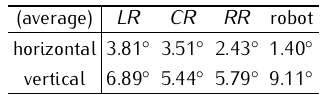
Table 1. Accuracies of Gaze-tracking for Each Region on the